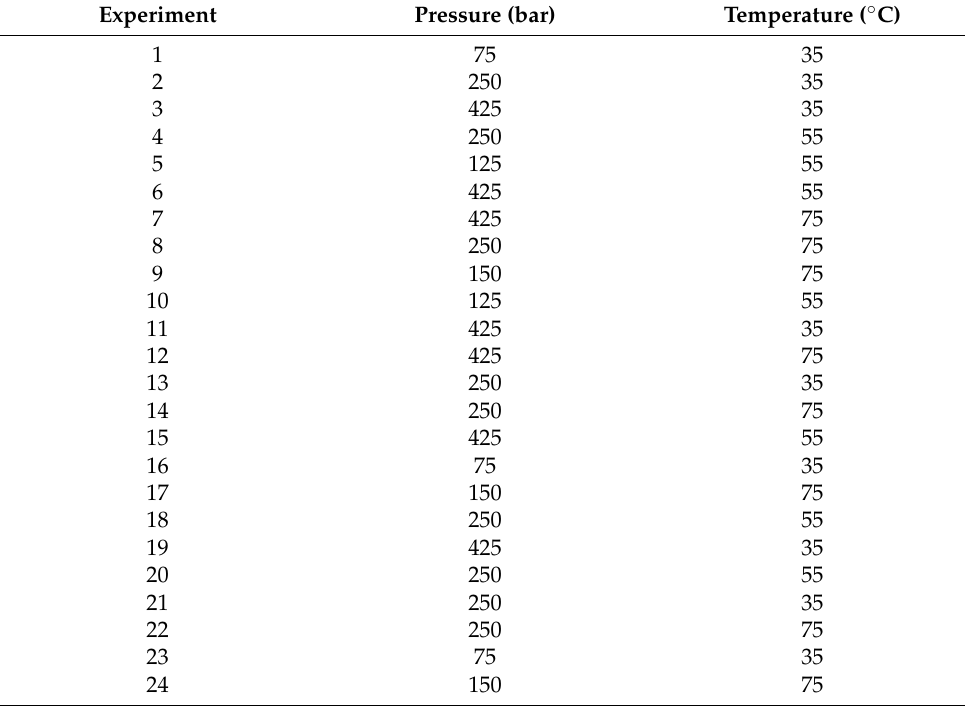
Figure 1. Simplified schematic depiction of the scCO 2 pilot plant unit. Table 1. Experimental conditions according to a full factorial design in the correct experimental